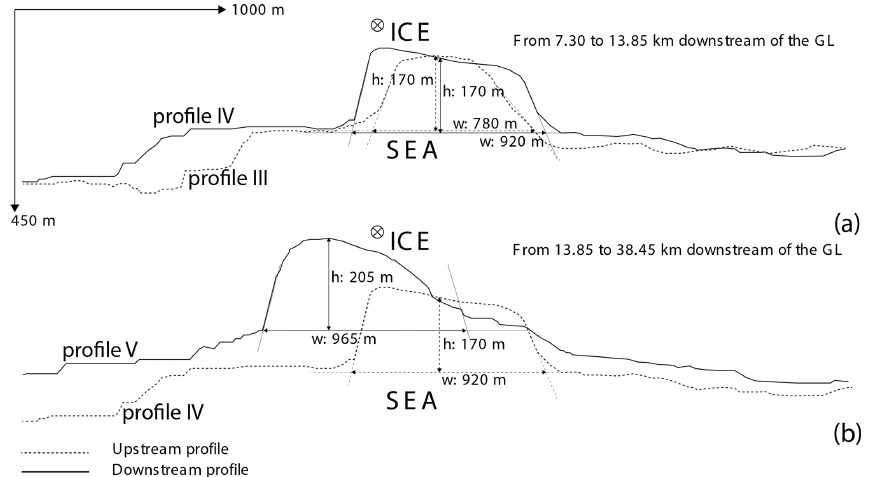
Figure 7. A schematic diagram of the ice shelf development around the basal channel derived from the three seismic across-flow profiles in Fig. 3. Vertically, they are positioned with respect to the ice shelf surface so that the ice thickness can be compared. (a) Comparing profile III (dashed line) with IV (continuous line). (b) Comparing profile IV (dashed line) with V (continuous